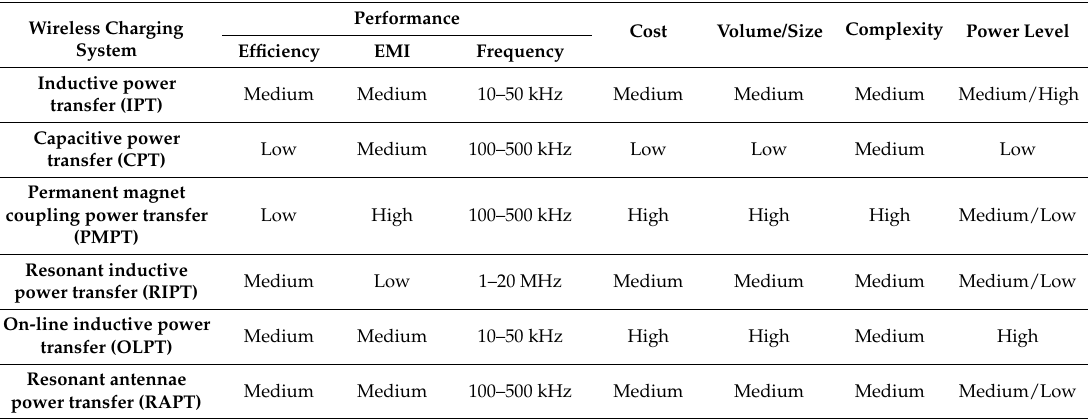
Table 21. Comparison of wireless charging